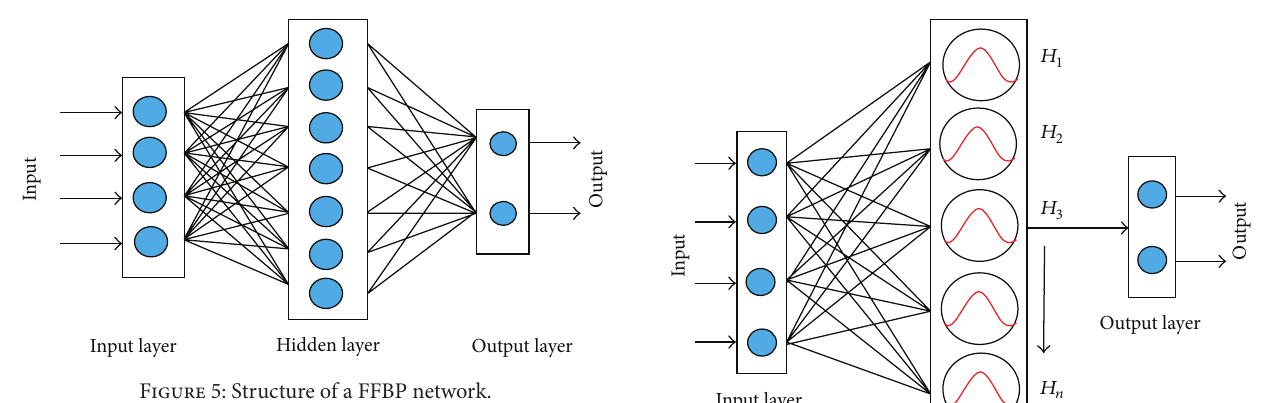
Figure 5: Structure of a FFBP network.